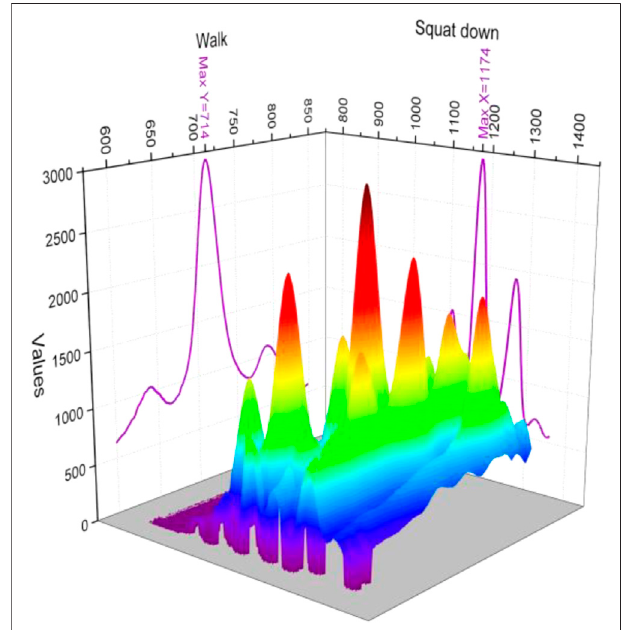
FIGURE 7 | Comparison of muscle signal fi ltering for deep squatting movements in the time domain. FIGURE 8 | Standard deviation of the broad fascial tensor for the four